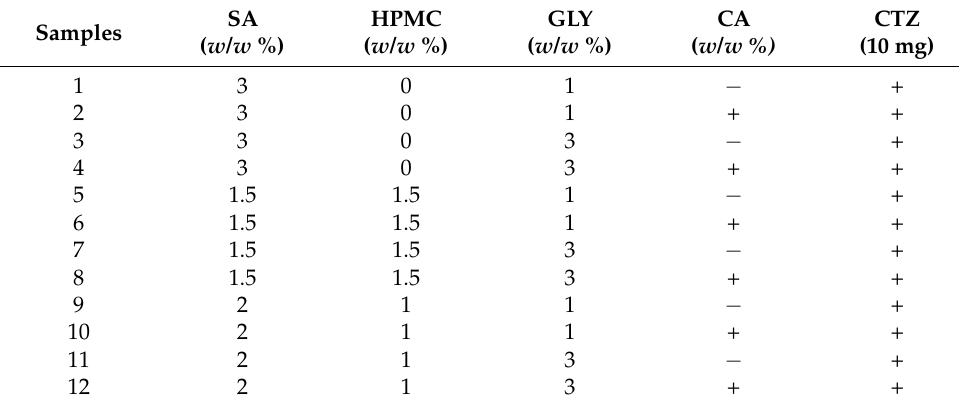
Table 1. Composition of different SA- and HPMC-based films.